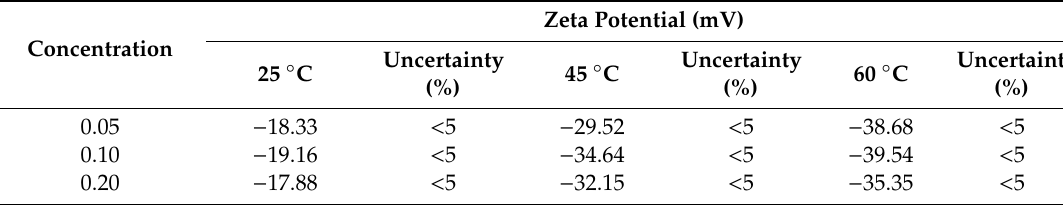
Figure 8. ( a ) UV–vis spectra of pure IL solution and nanofluids, ( b ) magnified view from 225 nm to 305 nm wavelength. Table 6. ζ -potential of ionanofluids di ff erent weight concentration Ti 3 C 2